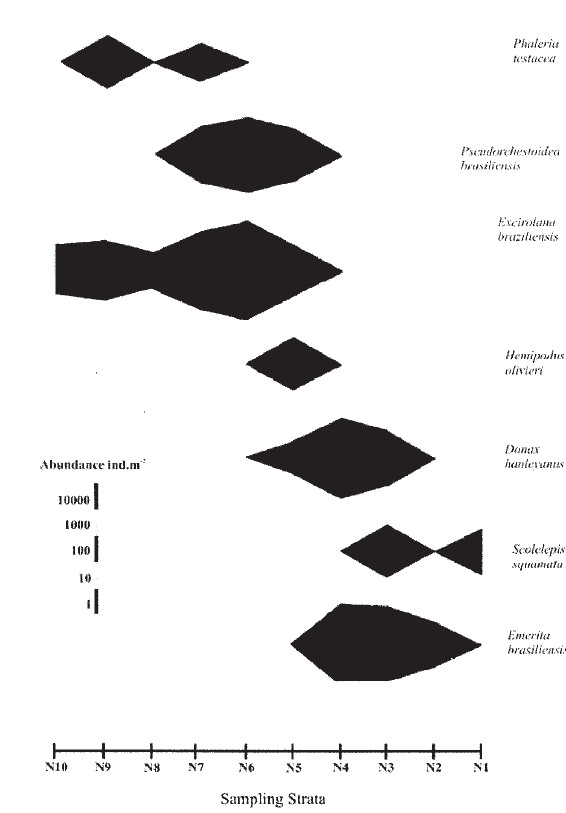
F IG . 4. – Diagram illustrating the three-zone pattern of macroinfauna zonation.